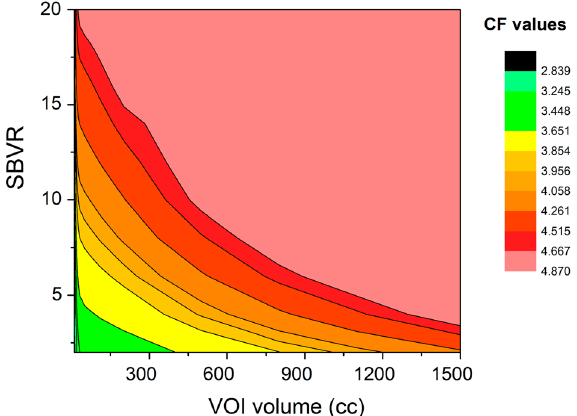
Fig. 6 Calibration factor map [cps/MBq] as function of sphere‑to‑background counts/voxel ratio (SBVR) and VOI volume